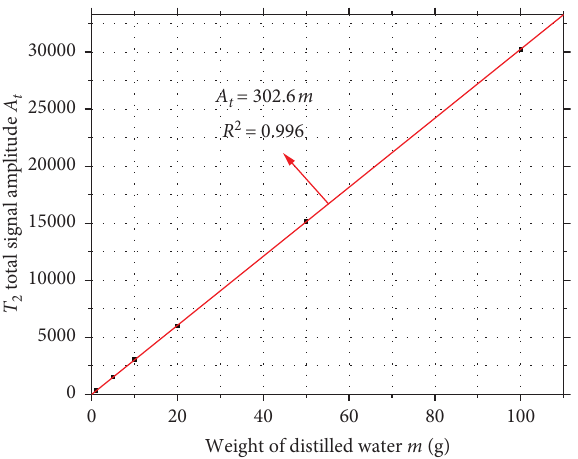
Figure 4: Relationship between the weight of distilled water in artificial clayey soil and the T 2 total signal